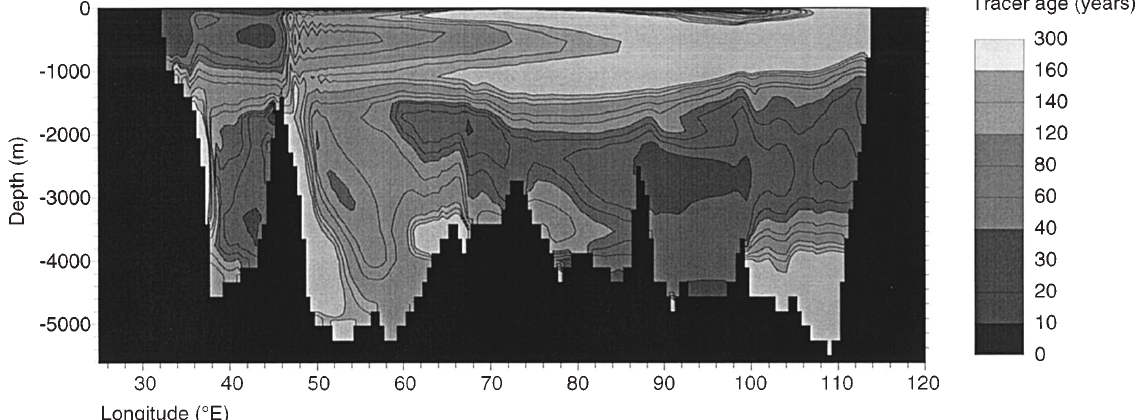
Fig. 5. A zonal section at 27 (cid:14) S from South Africa (30 (cid:14) E) to Australia (115 (cid:14) E), illustrating the age of tracer introduced at the Indian Ocean boundary (24